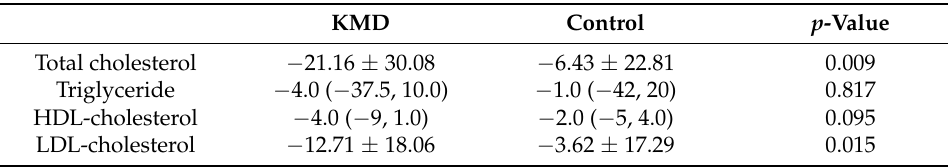
Table A3. Comparison of changes in lipid profile after period 1.